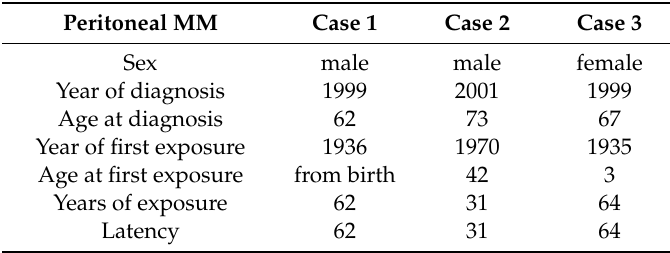
Table 2. Peritoneal MM cases.